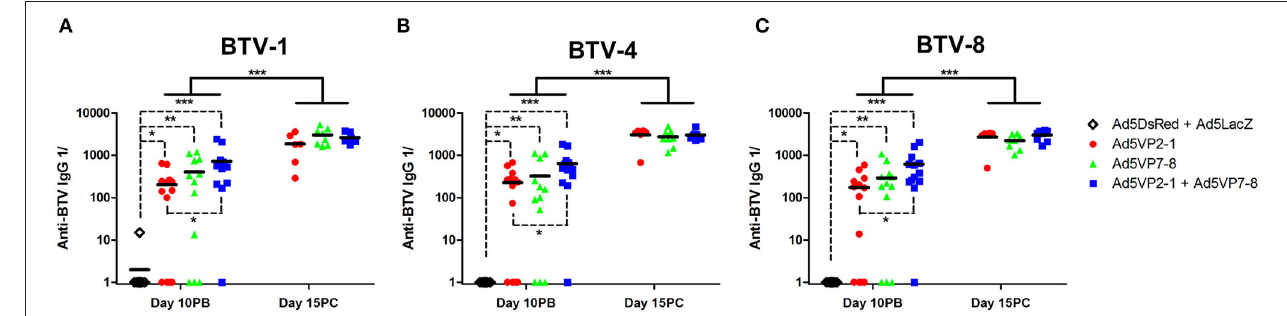
FIGURE 3 | The Ad5VP2-1 and Ad5VP7-8 immunization produces anti-BTV IgG that recognize heterologous BTV serotypes. The presence of anti-BTV IgG specific for (A) BTV-1, (B) BTV-4, and (C) BTV-8 in the sera of immunized mice was assessed by ELISA at day 10 post-boost (day 10PB; n = 12–14/group) and at day 15 post-challenge in surviving mice (day 15PC; n = 6–8/group). Data are presented as the reciprocal dilution (anti-BTV IgG 1/) necessary to achieve 2-fold absorbance for the naïve serum. * p < 0.05; ** p < 0.01; *** p < 0.001 [one-way ANOVA with Dunn’s post-test (Ad5DsRed + Ad5LacZ vs. Ad5VP2-1; Ad5VP7-8; or Ad5VP2-1 +